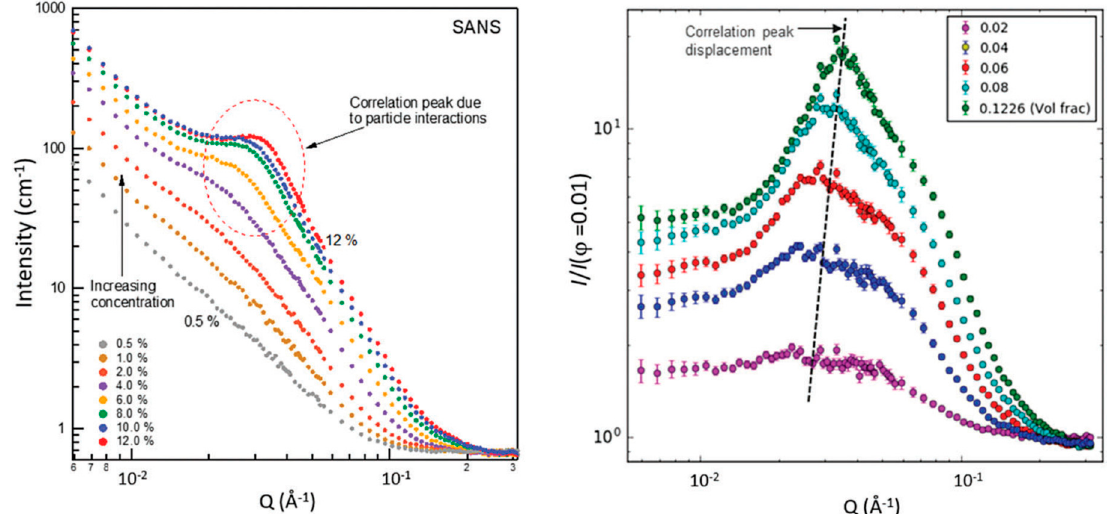
Figure 16. SAXS and SANS intensities normalized to the concentration of MNPs(Fe 3 O 4 /CA) with varying concentration. The SANS data have been background-subtracted for the H 2 O contribution. Reproduced from Reference [85] with permission from The Royal Society of Chemistry.